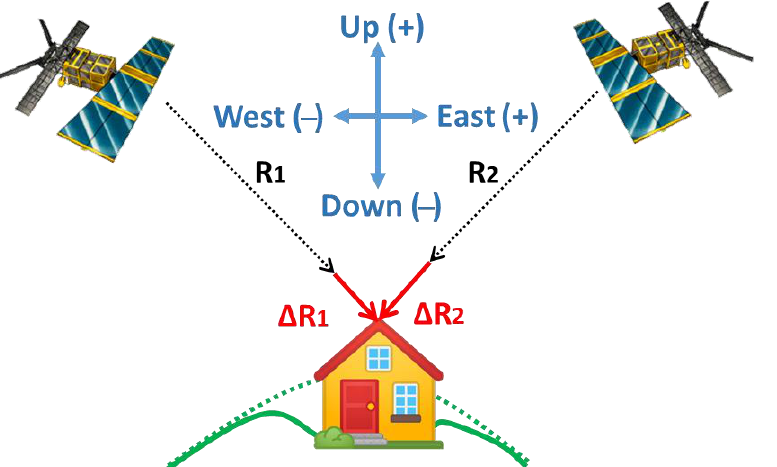
Figure 5. Sketch of the velocity of deformation projection along the vertical (up–down) and horizontal (east–west) directions. The projection can be performed if two satellite acquisition geometries (ascending and descending) are available.